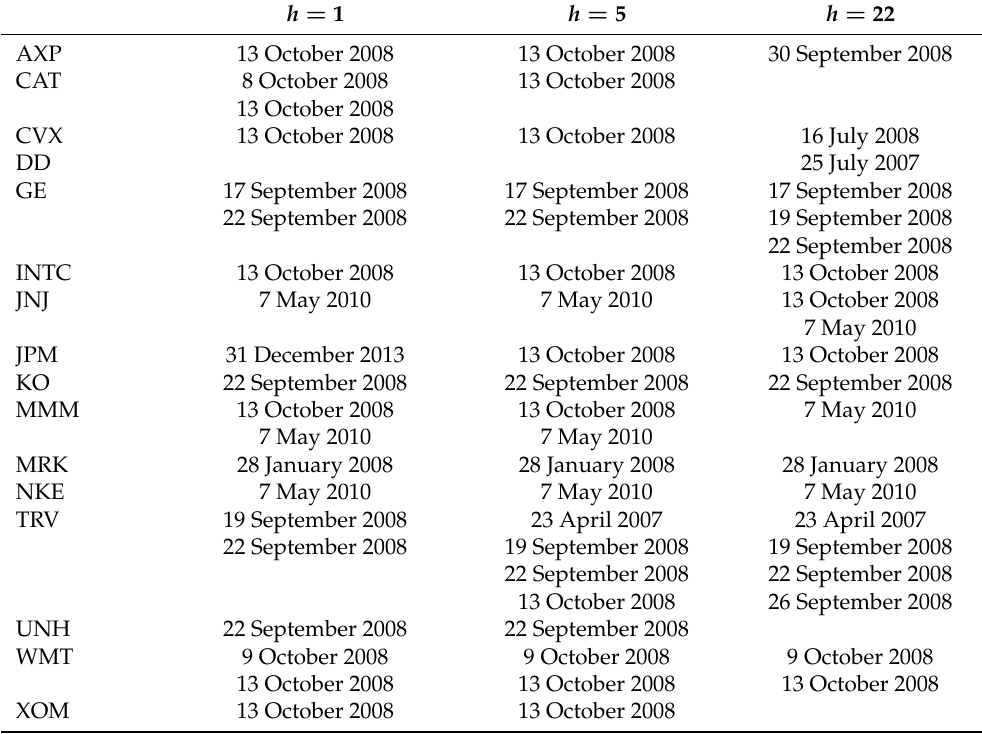
Table A4. Dates when HARQ predictions for RV are negative. The one month rolling forecast sample is from 3 January 2006 to 31 December 2013 (2013 trading